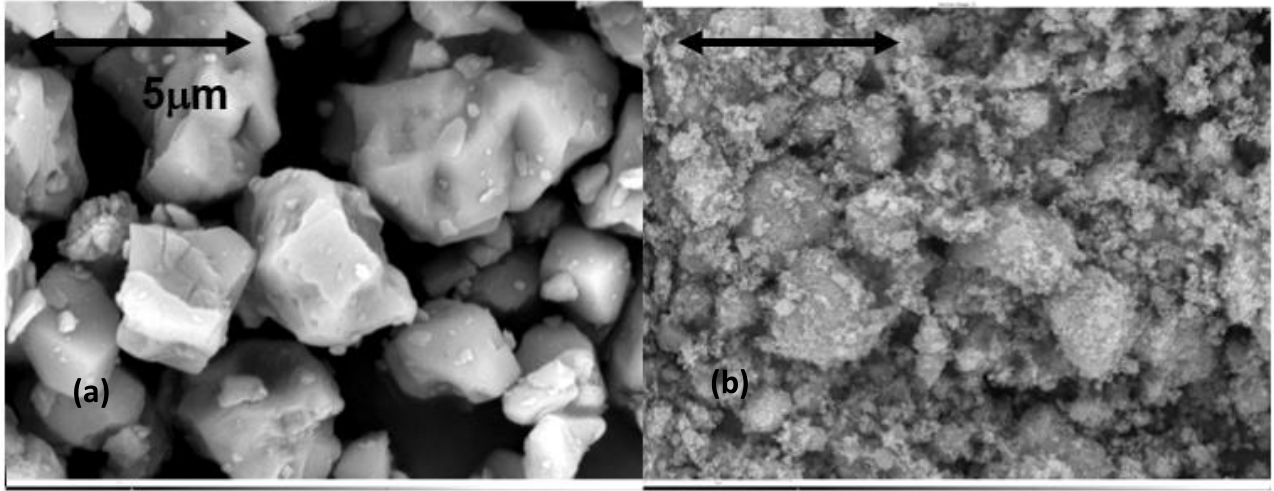
Figure 7. ( a ) CRM limestone and ( b ) calcium phosphate at higher magnification compared with a 5 μm scale. Table 1. Summary of the test materials used in this study.